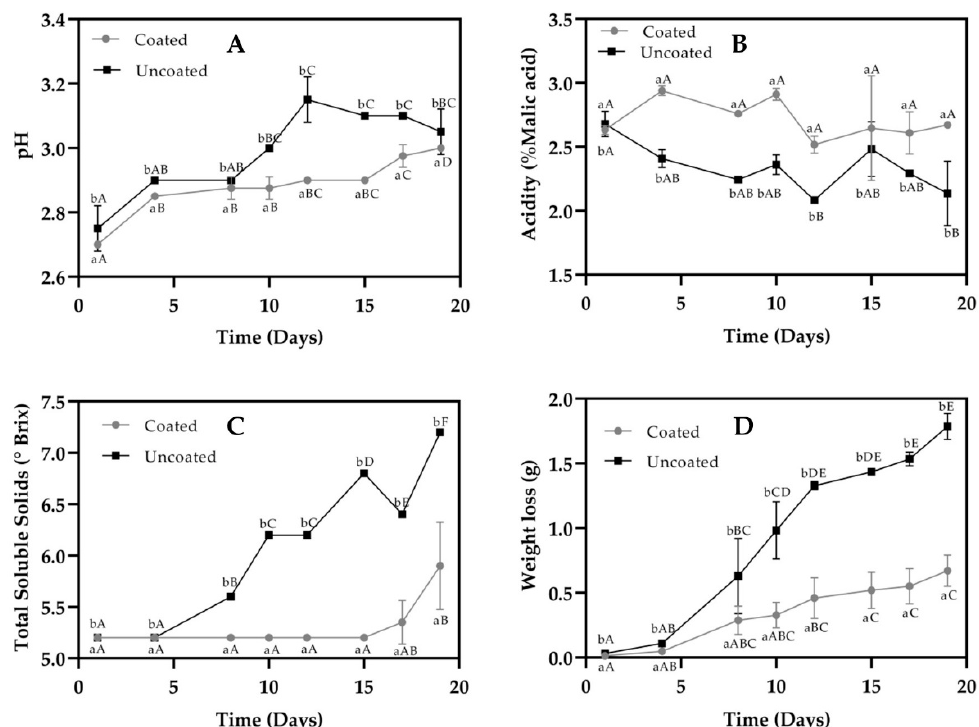
Figure 3. Monitoring the physicochemical properties of coated and uncoated fruits. ( A ) pH ( B ) Acidity ( C ) Total Soluble Solids ( D ) Weight loss. The averages with a common letter are not significantly different according to the Tukey test ( p ≥ 0.05). Uppercase letters differences between days and lowercase letters differences between material coated and uncoated fruits.